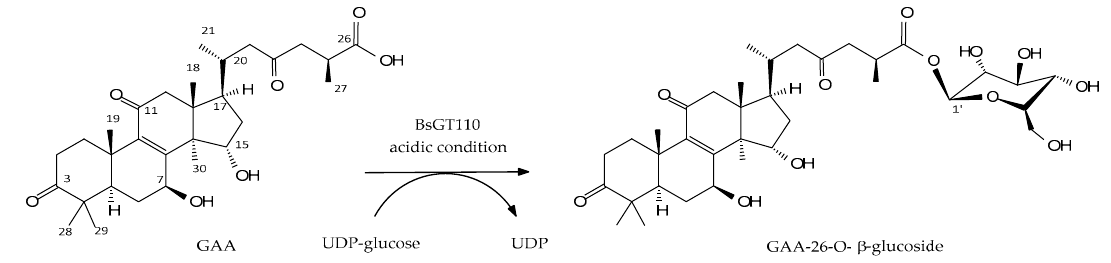
Figure 4. Biotransformation of GAA by BsGT110 in the acidic condition.